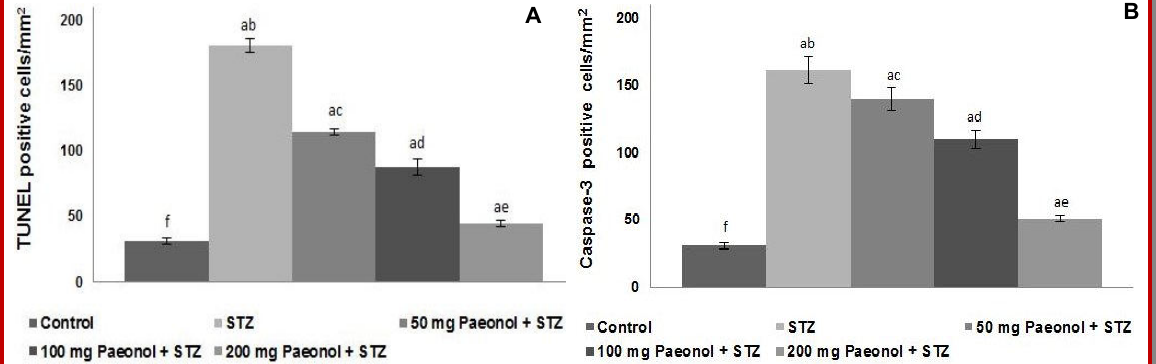
Figure 5: Paeonol reduces the intensive apoptosis in diabetic cardiomyopathy following streptozotocin (STZ) induction. Paeonol reduced the apoptotic cell counts markedly as determined by decrease in TUNEL positive cells (A) and also decreased the expres- sion of cleaved caspase-3 (B) Values are represented as mean ± SD, n=6. a represents statistical significance at p<0.05 compared against respective controls and b-f represents significant difference (p<0.05) between mean values within the groups as determined by one-way ANOVA followed by DMRT